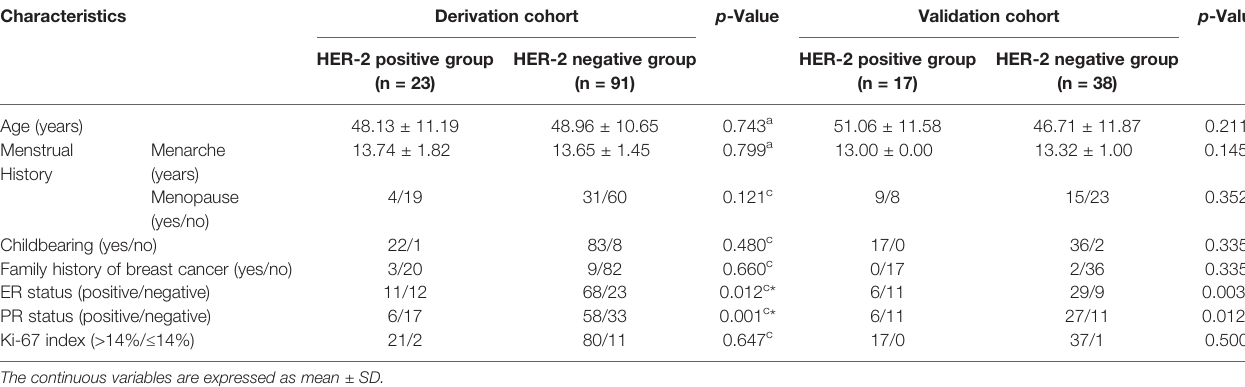
TABLE 2 | Demographic and clinical characteristics of participants in the derivation and validation cohorts.